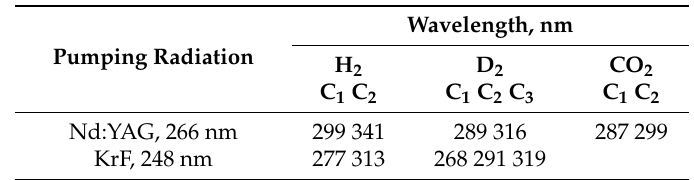
Table 2. Sets of wavelengths that correspond to Stokes (C) frequencies of SRS conversion in H 2 , D 2 , and CO 2